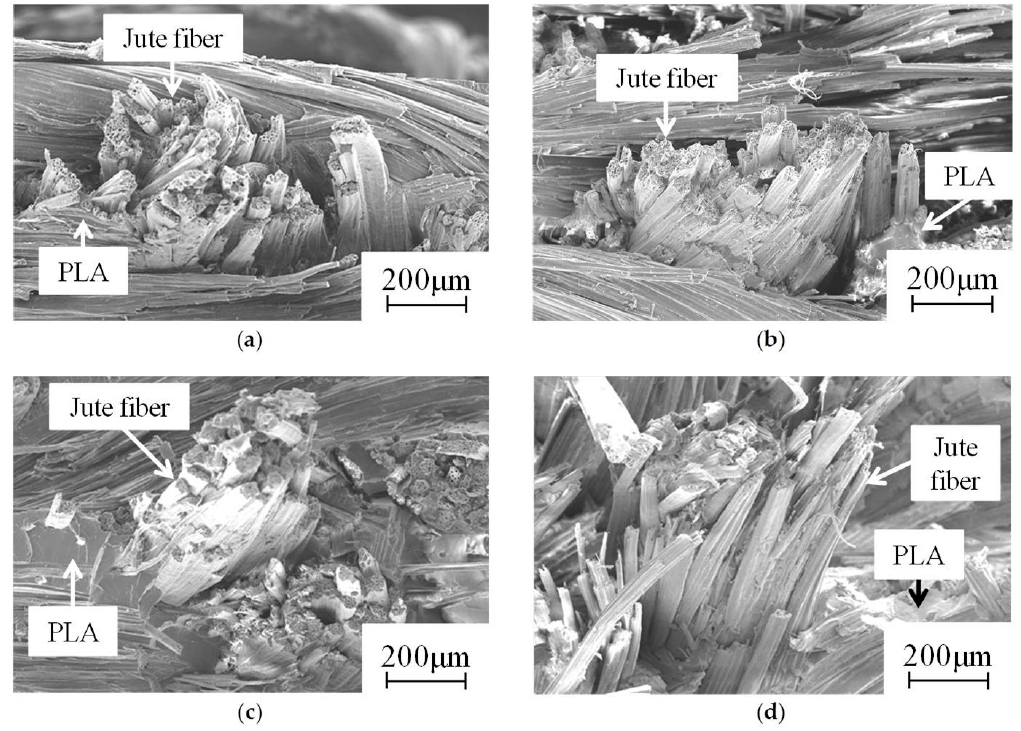
Figure 8. Fiber pull out in fracture surface of green composite after thermal cycling (35–45 °C): ( a ) 1 cycle; ( b ) 10 cycles; ( c ) 10 2 cycles; ( d ) 10 3 cycles.